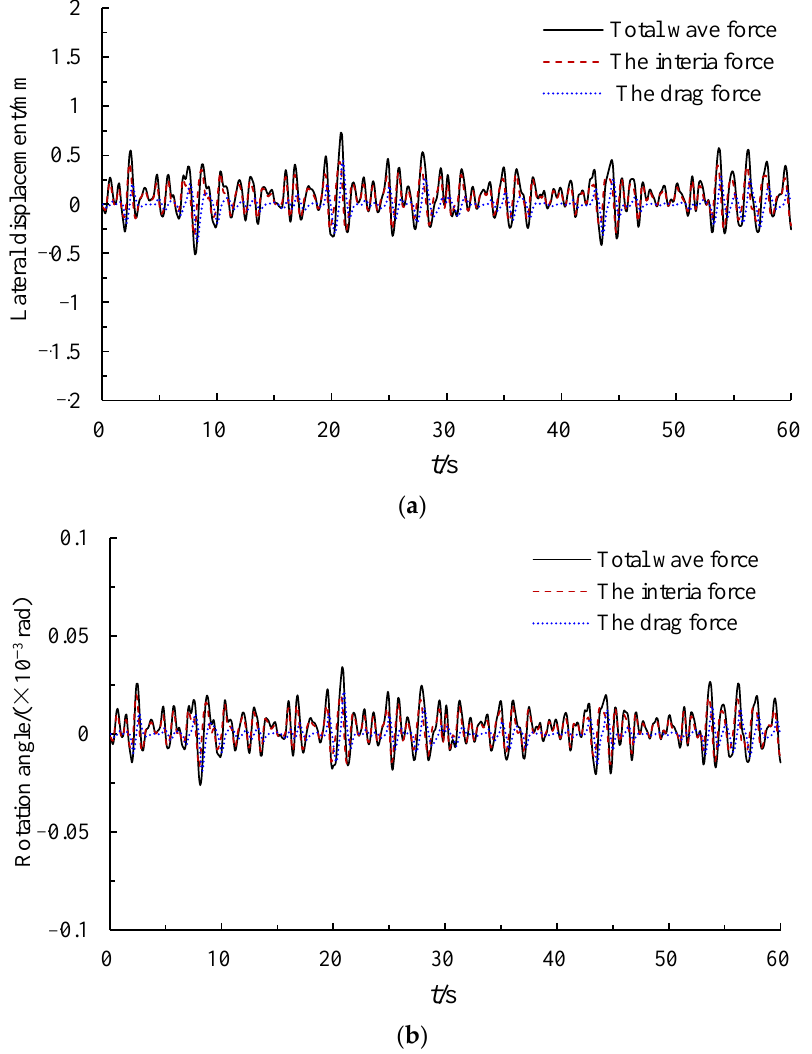
Figure 20. Dynamic response of the GBF when H 1/3 = 10 m: ( a ) lateral displacement, ( b ) rotation angle.